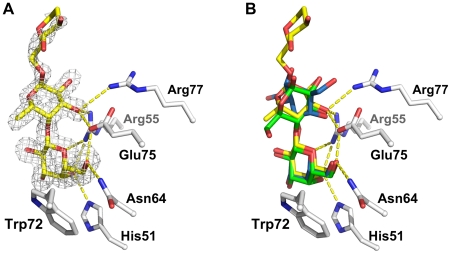
Detailed view of the interaction between CGL2 and Galβ1,4Fucα1,6GlcNAc (A) and comparison with two other CGL2/carbohydrate complexes (B).(A) Fourier difference map (with Fo - Fc coefficients) around the visible part of ligand contoured at 3 σ. Residues belonging to the binding pocket are displayed as sticks and H-bonds as dashed yellow lines. (B) Superimposition of the lactose (Galβ1,4Glc) (green, PDB ID 1ULC) and of the Thomsen-Friedenreich antigen (Galβ1,3GalNAc) (blue, PDB ID 1ULG) onto the CGL2/Galβ1,4Fucα1,6GlcNAc structure (yellow, PDB ID 2WKK). The binding pocket is almost identical in all three structures.